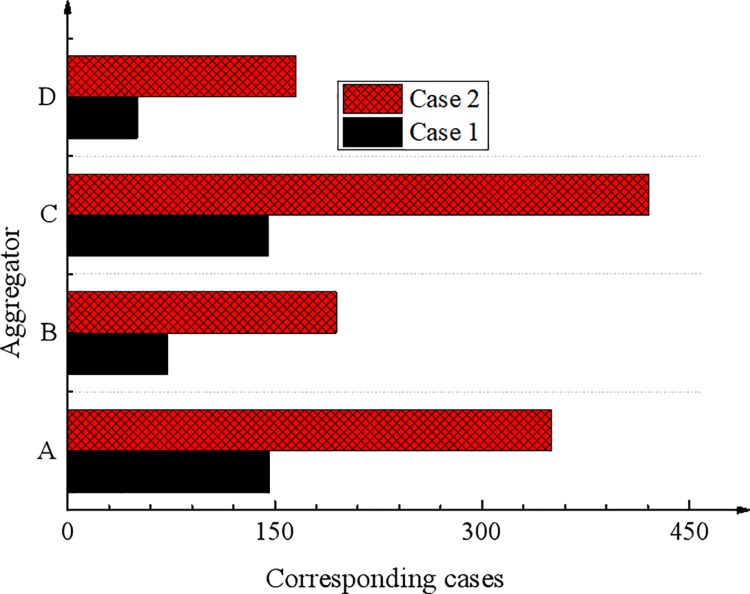
Comparison of aggregators’ revenue based on Case 1 and Case 2.